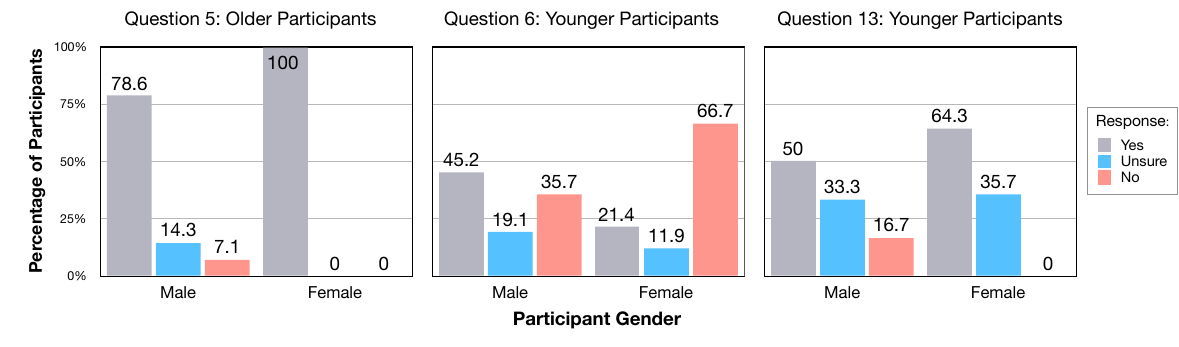
Figure 7: Gender differences among participants in each study across all types of interviewers.